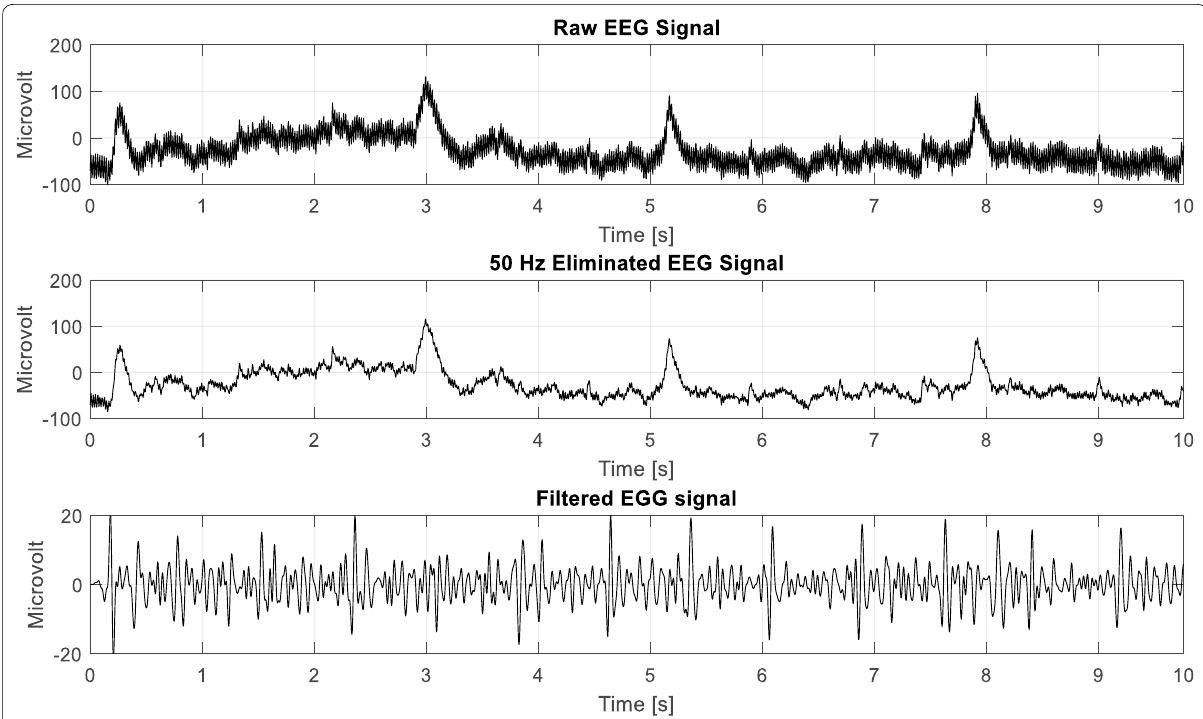
Fig. 4 Original EEG signal and its stepwise filtering effect (according to the proposal) on the